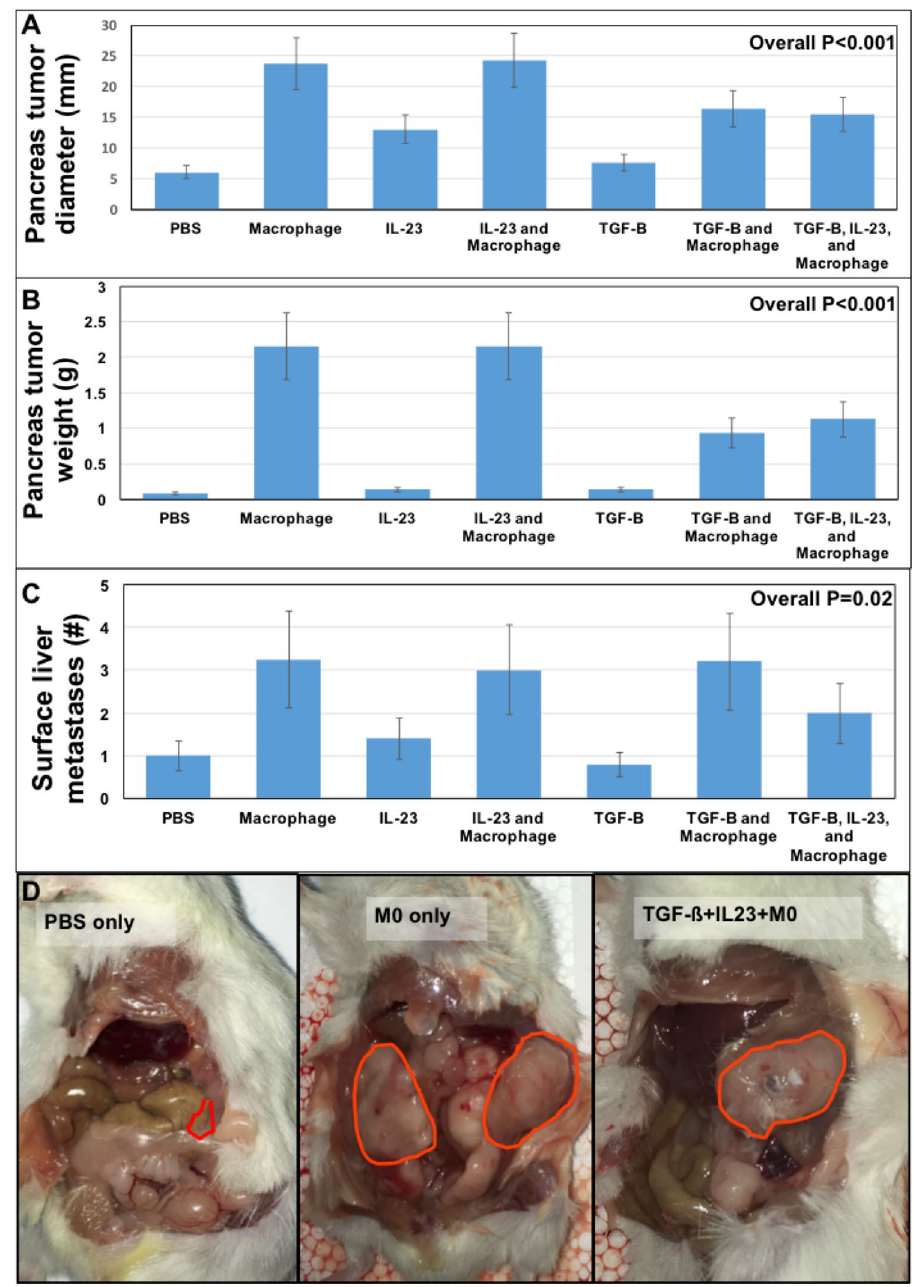
Figure 4. Macrophage co-culture with PDAC in vivo increases tumorigenesis and metastases while IL23 and TGF-ß abrogate these phenomena. Panc-1 cells co-cultured with macrophages alone or in combination with IL23 or TGF-ß had primary tumors that were significantly larger by weight and diameter ( A , B , P < 0.001) when Panc-1 cells were exposed to macrophages but this was diminished when pre-treatment included IL23 or TGF-ß. Metastatic PDAC tumors to the liver after orthotopic implantation were larger when co-cultured with macrophages compared to controls ( C , P = 0.02). Tumor burden after 4 weeks was significantly less when Panc-1 cells co-cultured with macrophages were pre-treated with IL23 and TGF-ß compared to macrophage co- culture alone ( D ). Macrophage co-culture with Panc-1 cells increases tumorigenesis and metastases formation (outlined in red) while combined IL23 and TGF-ß treatment diminishes these